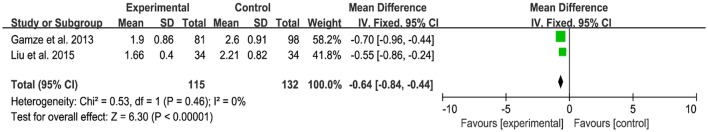
Forest plot of duration of phototherapy.